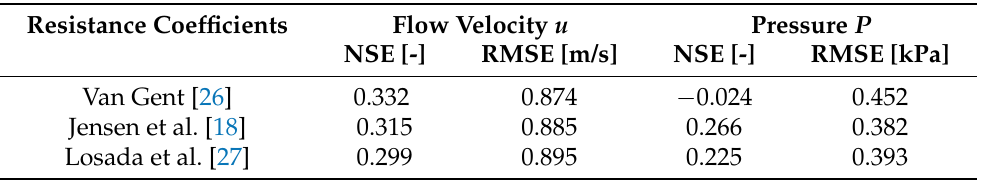
Table 5. Performance indicators of the flow velocity u and the pressure P for the three sets of resistance coefficients.